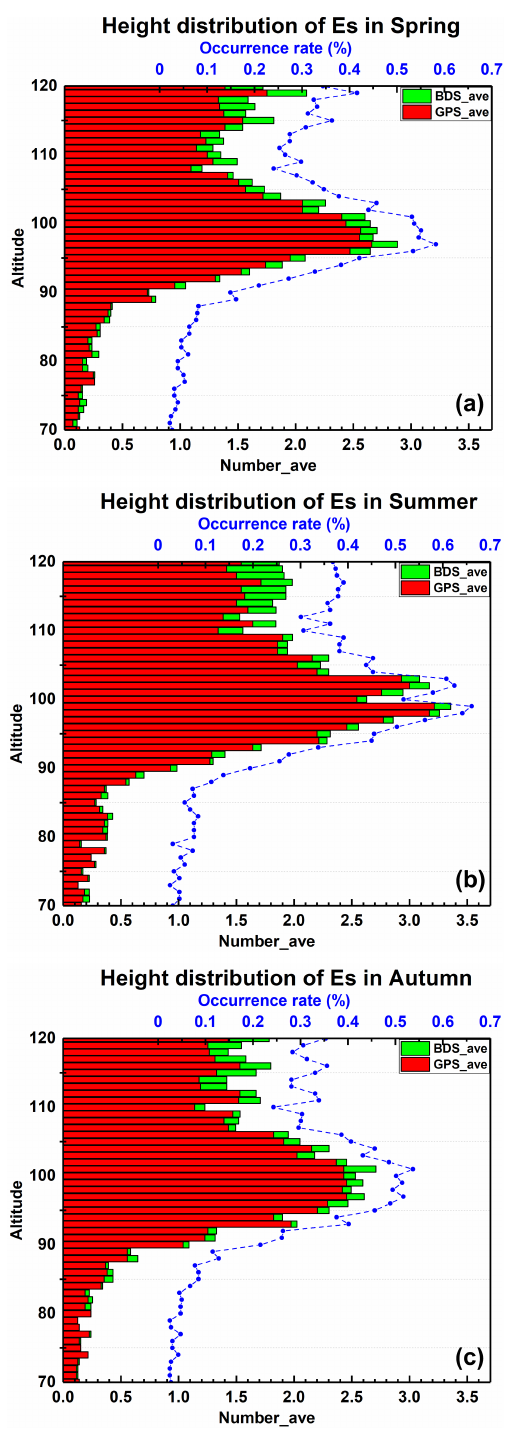
Figure 3. Height distribution of E s average daily occurrence rate for three different seasons, Panels (a–c) are the results of spring, sum- mer, and autumn, respectively. The blue dotted line diagram shows E s occurrence rate, the red and green bar chart shows the number of occultation events with E s events per